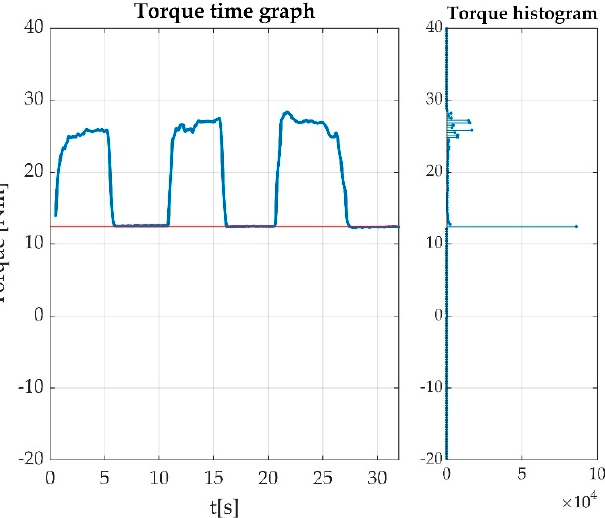
Figure 7. A successful offset detection as the histogram maximum. The histogram is represented in the right part of the time graph. The maximum value on the histogram represents the measurement offset value marked with a red line on the time graph.